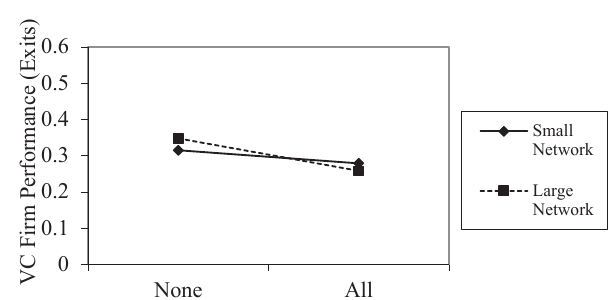
Figure 3. The moderating effect of network on the association between early stage investment and VC firm performance